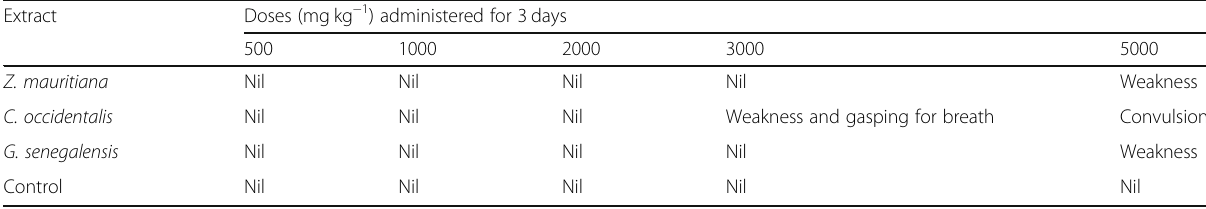
Nil no reaction; number of rats per group ( n ) =